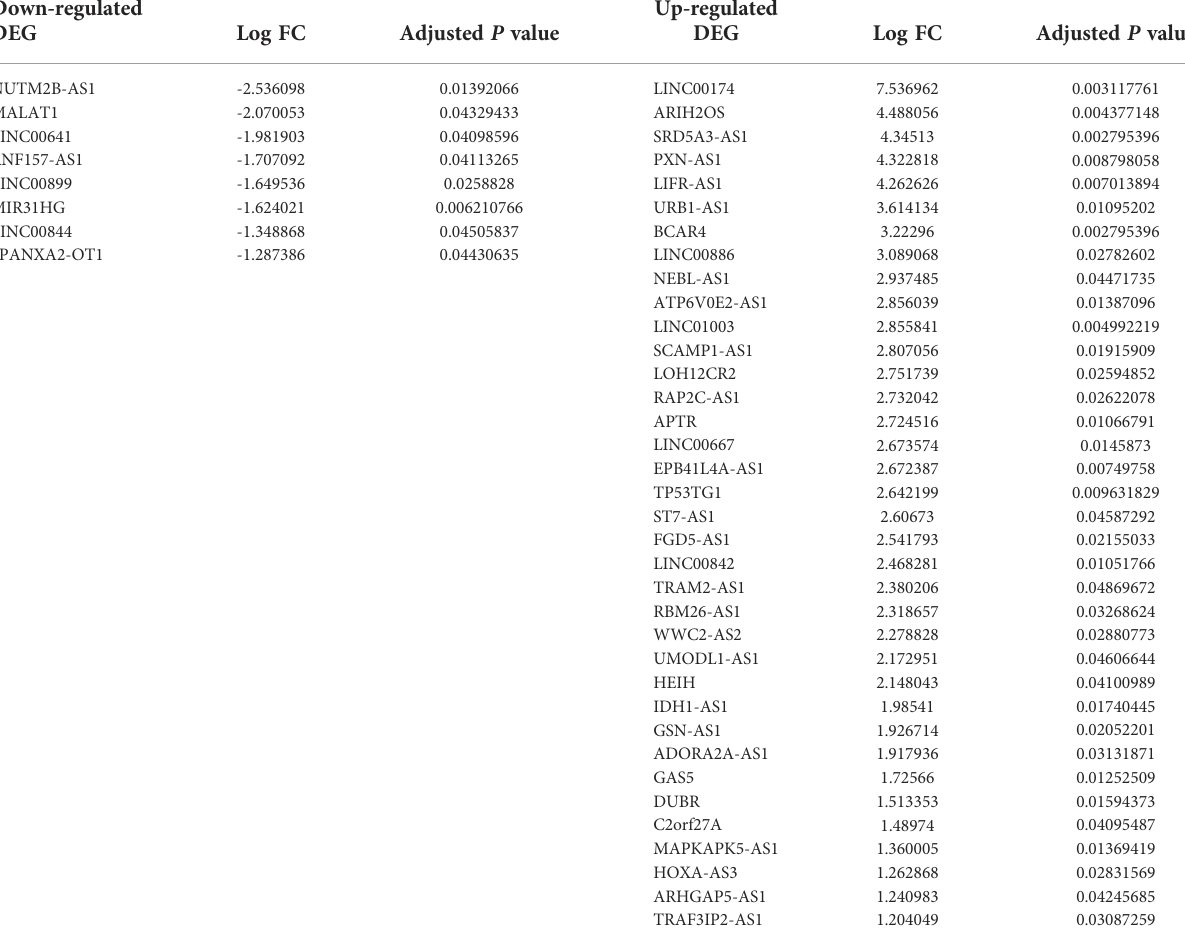
TABLE 2 The signi fi cantly up- and downregulated DElncRNAs between NFPA and normal samples.